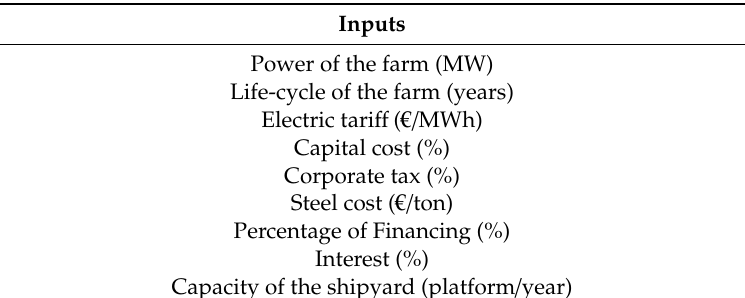
Table 2. Inputs of the software II.